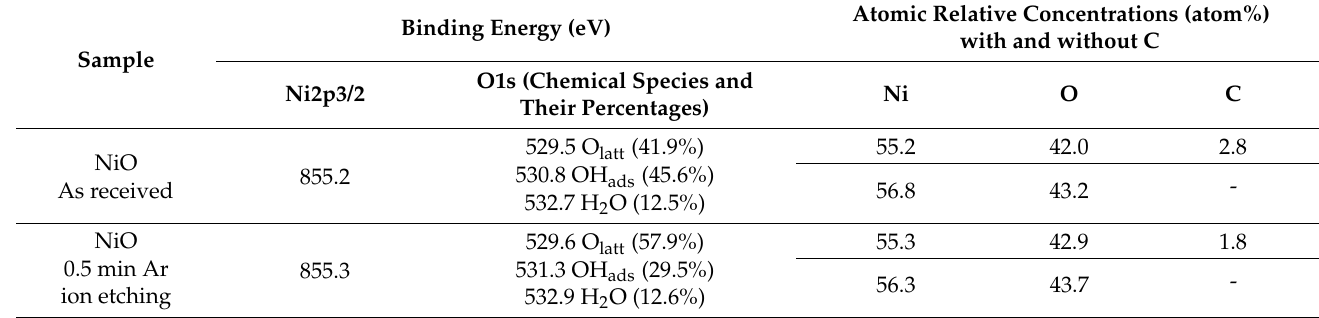
Table 1. XPS data: photoelectron lines, binding energies (BEs—eV), chemical species, atomic relative concentrations (atom%).